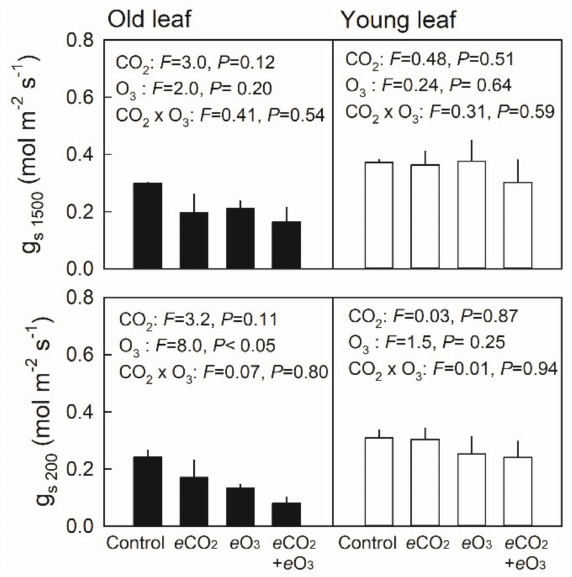
Figure 4. Stomatal conductance (g s ) under saturating (upper panel) or limiting light intensity (lower panel) in old (closed bar) and young leaves (open bar) of Japanese white birch seedlings grown under the CO 2 and O 3 treatment combinations. Control—ambient air, eCO 2 —elevated CO 2 , eO 3 —elevated O 3 , and eCO 2 + eO 3 —elevated CO 2 and O 3 . Young leaves were ≈ 30 days old, and old leaves were ≈ 60 days old. Measurements were conducted under the respective growth CO 2 concentrations, where a CO 2 concentration of 380 µ mol mol − 1 was applied for control and eO 3 plants, and that of 550 µ mol mol − 1 was applied for eCO 2 and eCO 2 +eO 3 plants. F -value and probability ( P ) of the effects of CO 2 , O 3 and their interaction are indicated in the panel. Values are mean + SE ( n = 3).